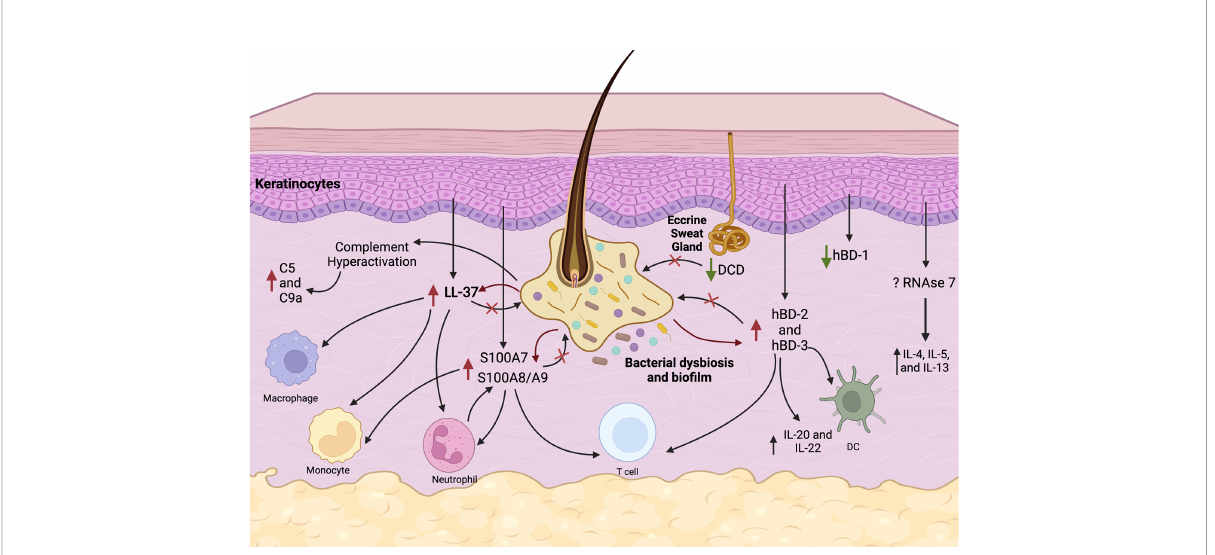
FIGURE 1 Proposed pathways of AMPs and complement deregulation in HS. Follicular in fl ammation, microbial dysbiosis and bio fi lm stimulate keratinocytes to overexpress LL-37 (cathelicidin), S100A7, S100A8/A9, hBD-2, and hBD-3. Immunomodulatory function of these AMPs includes chemotaxis of macrophages, monocytes, neutrophils, T cells, and dendritic cells (DC) and production of cytokines. Complement pathways are hyperactivated in HS causing elevated C5a and C9 levels. Constitutive production of hBD-1 from keratinocytes and DCD production from eccrine sweat glands is inhibited in HS skin which may result in microbial dysbiosis. Overall, these events lead to a persistent vicious cycle of chronic in fl ammation, which is ineffective in eliminating pathogens and bio fi